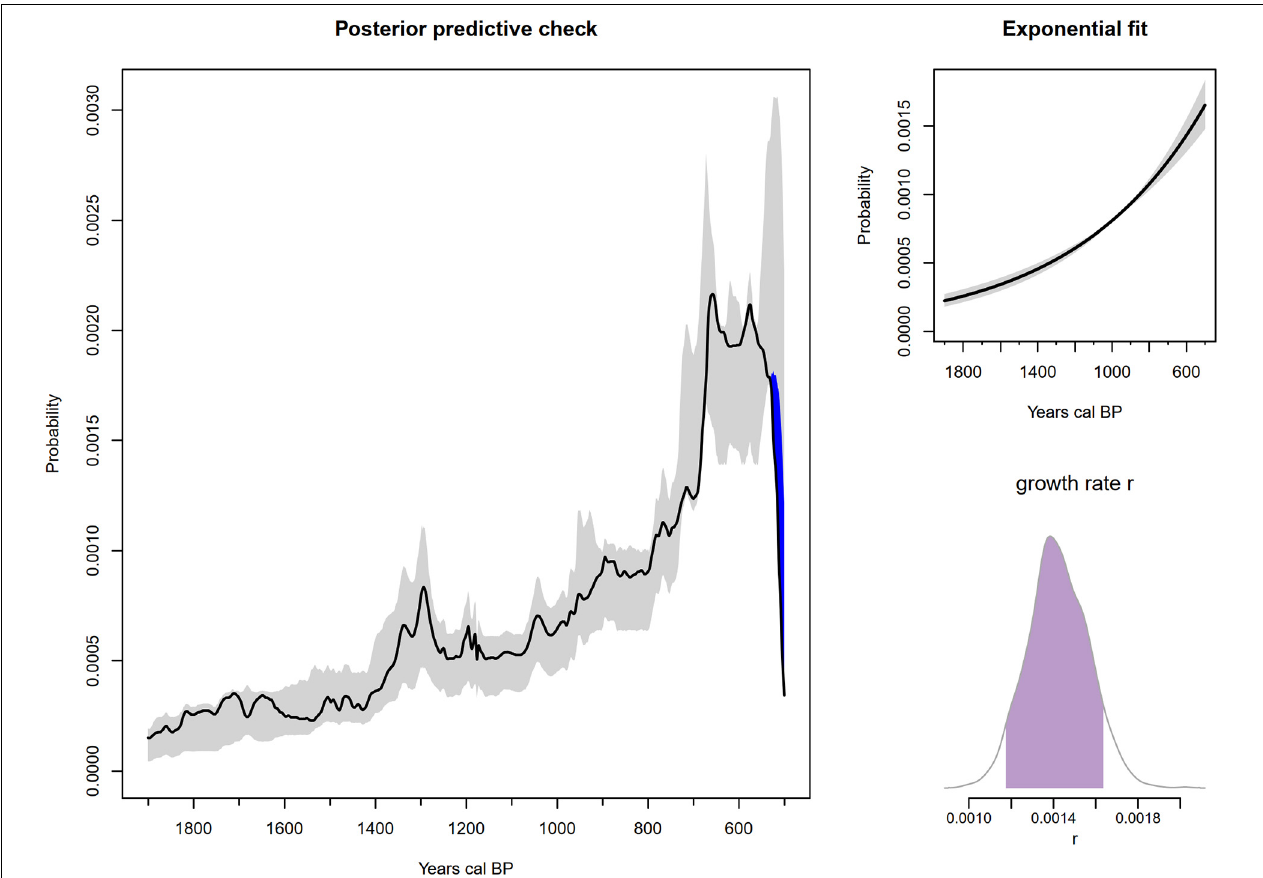
FIGURE 4 | Results of Bayesian radiocarbon analysis. Left: results of posterior predictive check, showing the empirical Atlantic Forest SPD (black line) within the prediction range of the fitted model (grey envelope), excepting close to the Conquest. Bottom right: marginal posterior distribution of the growth rate r over the interval 1,900–500 cal BP. Top right: exponential model